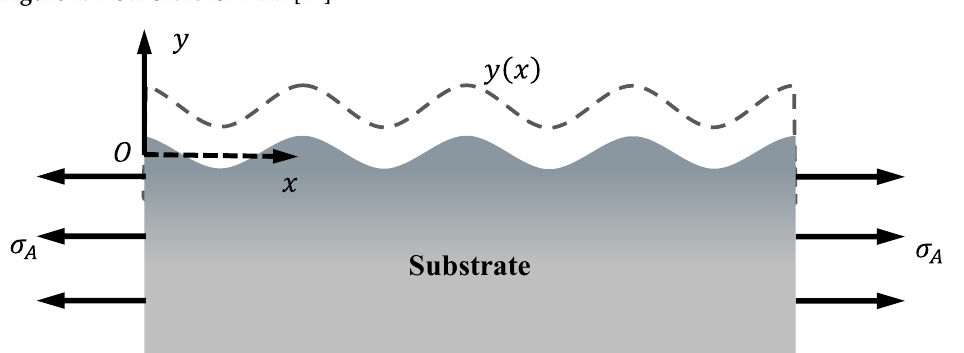
Figure 4. Flow chart for FEM [41].